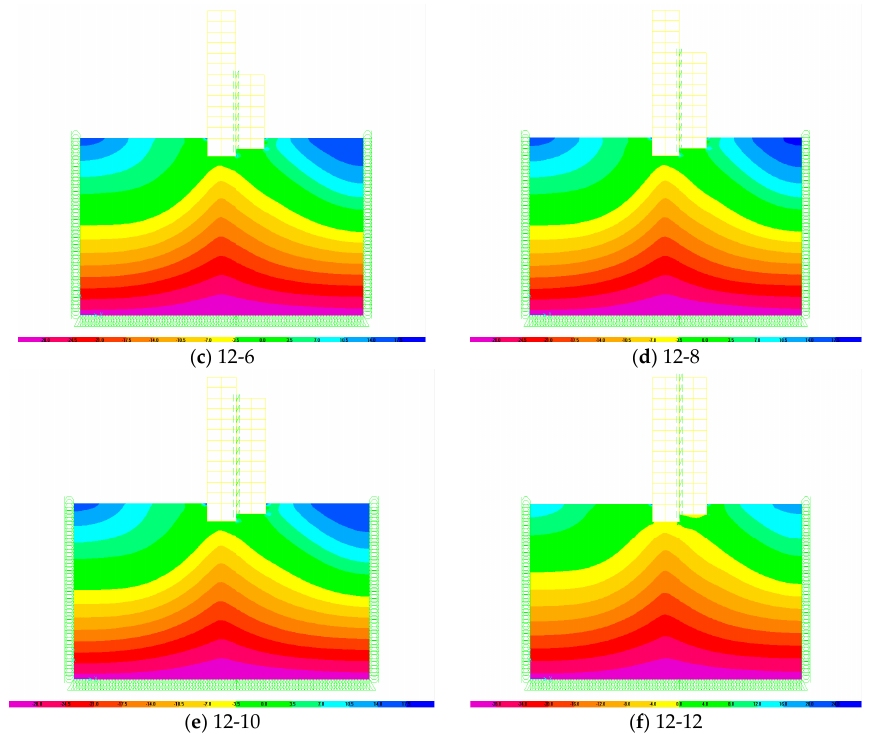
Figure 22. Lateral soil stresses (KN/m 2 ) for the two adjacent buildings with unequal foundation levels.